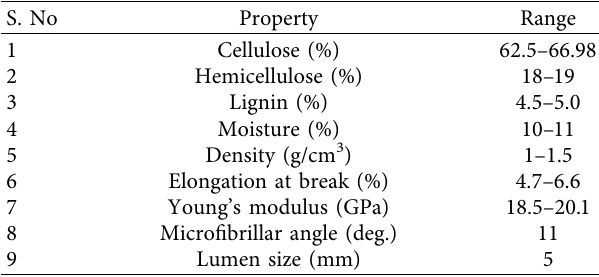
Table 1: Physical properties of the banana fiber